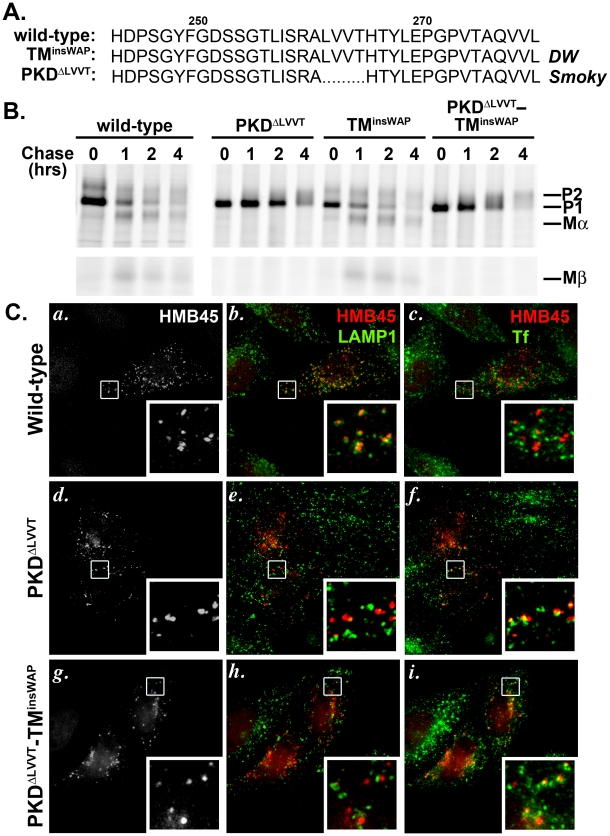
The PKDΔLLVT secondary mutation found in the Smoky chicken PMEL prevents delivery of TMinsWAP mutant hPMEL to fibrillogenic compartments.A. Sequence of PKD domain residues 245–280 in wild-type and mutant hPMEL. The PMEL gene in the Smoky chicken harbors an in-frame deletion that eliminates four amino acids from the PKD domain, corresponding to LVVT in hPMEL (PKDΔLLVT), in addition to the TMinsWAP mutation. B. Metabolic labeling/pulse chase analysis of HeLa cells transiently transfected with wild-type, PKDΔLVVT, TMinsWAP or PKDΔLVVT-TMinsWAP variants of hPMEL. Cells were labeled, chased and Triton X-100-soluble cell lysates were immunoprecipitated with an antibody to the hPMEL C-terminus as in Figure 3C. Note that variants bearing the PKDΔLVVT deletion, regardless of the presence of the TMinsWAP insertion, do not mature efficiently to P2 and fail to accumulate Mα and Mβ fragments. C. IFM analysis of HeLa cells transiently expressing wild-type (a–c), PKDΔLVVT (d–f) or PKDΔLVVT-TMinsWAP (g–i) variants of hPMEL. Cells were fixed after exposure for 30 min at 37°C to fluorophore-conjugated transferrin (Tf) to label early sorting and recycling endosomes, then stained with an antibody that recognizes only mature PMEL (HMB45) and an anti-LAMP1 antibody. Left panels (a, d, g) show PMEL labeling only; middle panels (b, e, h) show overlap of LAMP1 (green) and HMB45-labeled PMEL (pseudocolored red); and right panels (c, f, i) show overlap of internalized Tf (green) and PMEL (red). Insets show a 4X magnification of the boxed areas. Note that wild-type PMEL overlaps with LAMP1 but not internalized Tf, whereas PKDΔLLVT overlaps partially with Tf but not LAMP1.